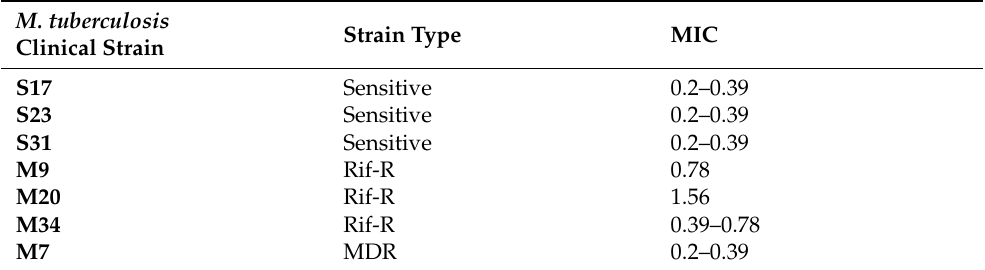
Table 2. MICs of compound 1 against seven M. tuberculosis clinical strains. MICs in µ g/mL. Different MIC values for the same strain come from independent experiments.